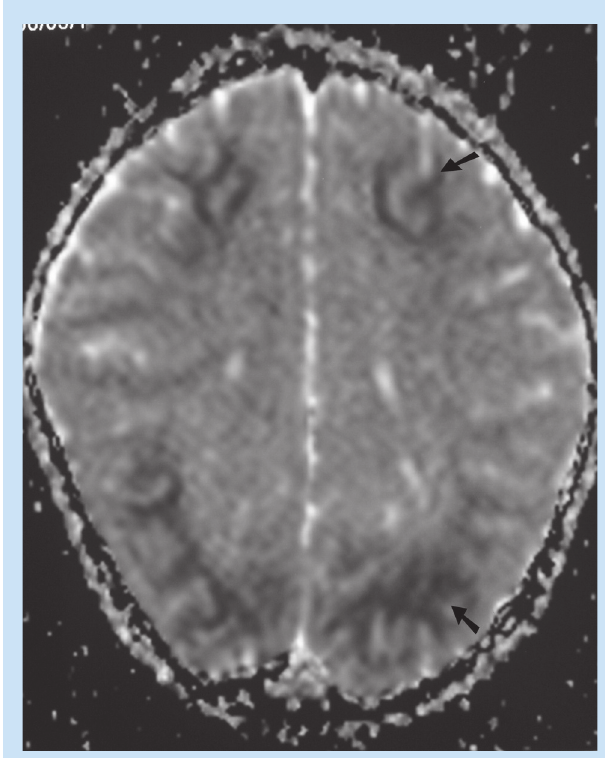
Fig. 2.4f. ADC map demonstrates inversion of the high signal abnormality seen at both anterior and posterior watershed regions (arrows) on DWI in a patient with a global hypoxic event. Reversal of the high DWI signal to a low ADC map signal confirms restricted diffusion associated with ischaemic